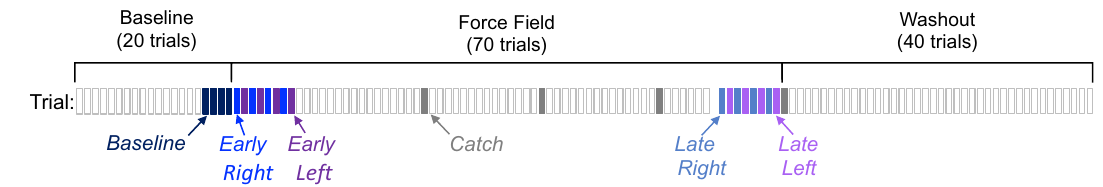
Figure 2. Protocol Participants performed 130 consecutive trials, each represented as a rectangular block ordered left to right. The force field was applied during Force Field trials (except for catch trials) and absent during Baseline and Washout trials. Data was analyzed during six distinct experimental four-trial periods highlighted in their respective